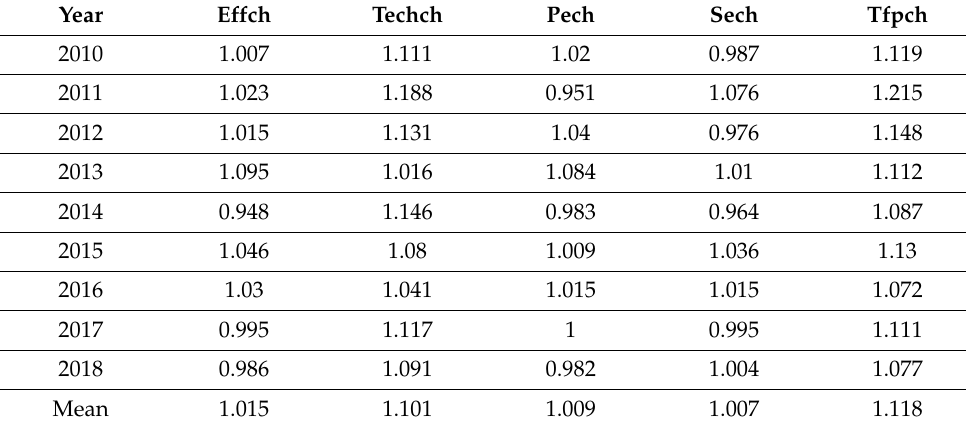
Table 3. Decomposition results of forestry total factor productivity in three stages from 2009 to 2018 (after